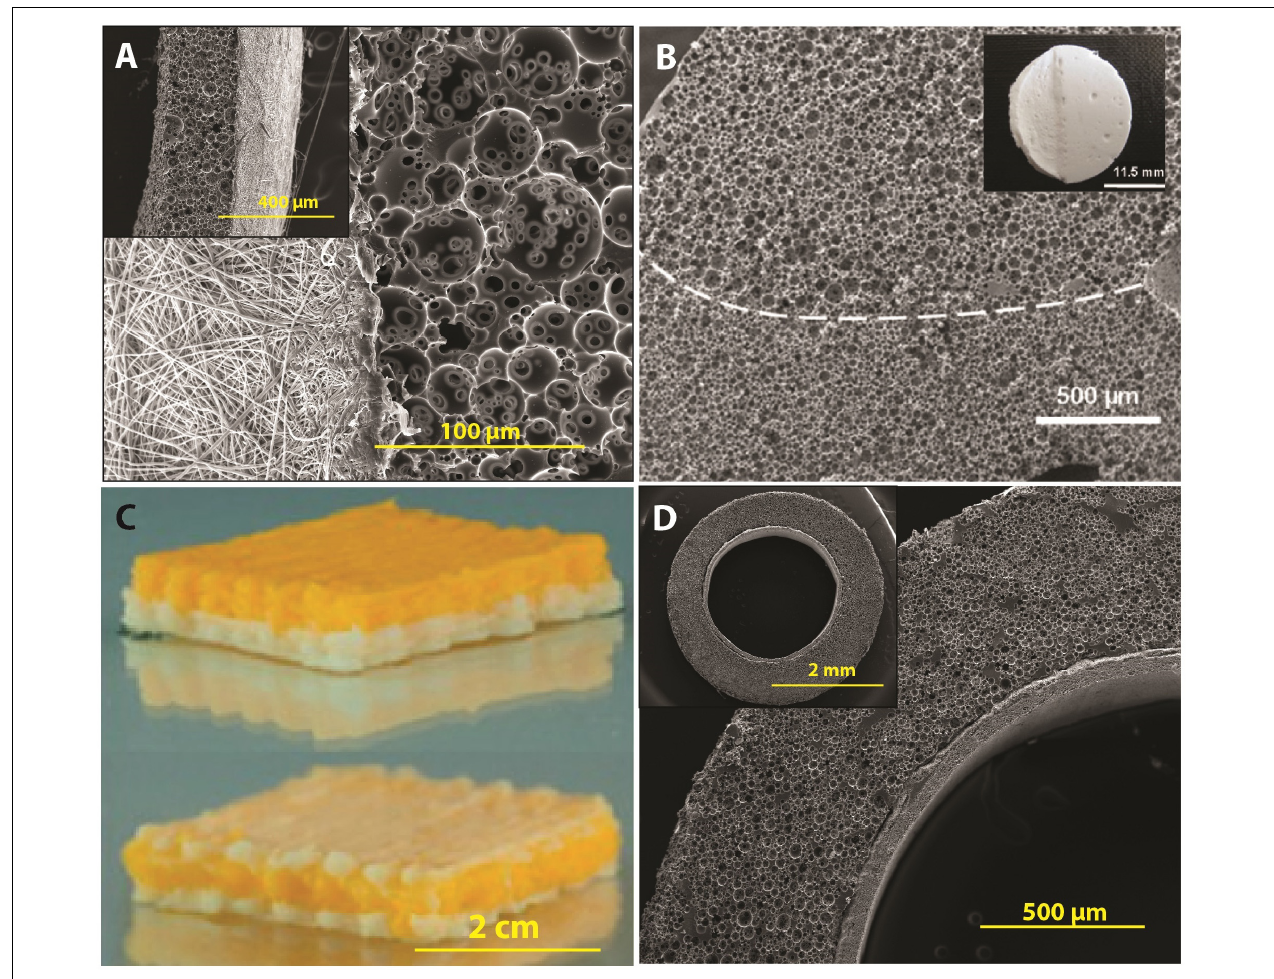
FIGURE 12 | Hybrid PolyHIPE scaffolds with multiple layers: (A) emulsion templating combined with electrospinning for development of a membrane for guided bone regeneration, (B) PolyHIPEs with two different morphologies, (C) 3D printing of drug-loaded and drug-free HIPEs selectively, and (D) emulsion templating combined with electrospinning in a tubular form for the development of in vitro angiogenesis model. Images (A,D) were reproduced with permission from Ref. Aldemir Dikici et al. (2019a) and Dikici et al. (2020a), respectively, under The Creative Commons License. Image (B) was adapted with permission from Langford et al. (2015), Copyright 2015 John Wiley and Sons. Image (C) was adapted with permission from Yang et al. (2017), Copyright 2017 American Chemical